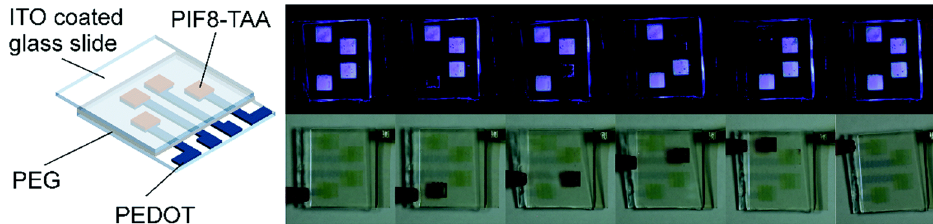
Figure 11. EFCDs with printed electrodes and electrofluorochromic layers under operation [90].